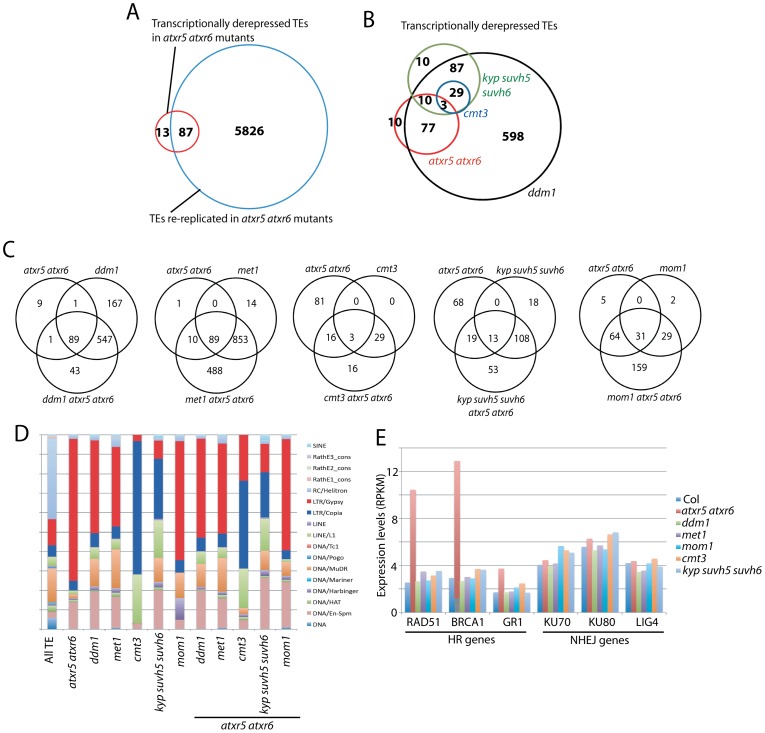
Relationship between ATXR5/6 and DNA methylation in transcriptionally silencing TEs.A. Overlap of re-replicated TEs in atxr5 atxr6 mutants, with transcriptionally reactivated TEs in atxr5 atxr6 mutants. B. Overlap of TEs transcriptionally derepressed in atxr5 atxr6 mutants and DNA methylation mutants. C. Overlap of TEs derepressed in indicated mutants. D. TE families of derepressed TEs in indicated mutants. E. Normalized expression levels of key genes in homologous recombination (HR) and non-homologous end-joining (NHEJ) DNA repair pathways.